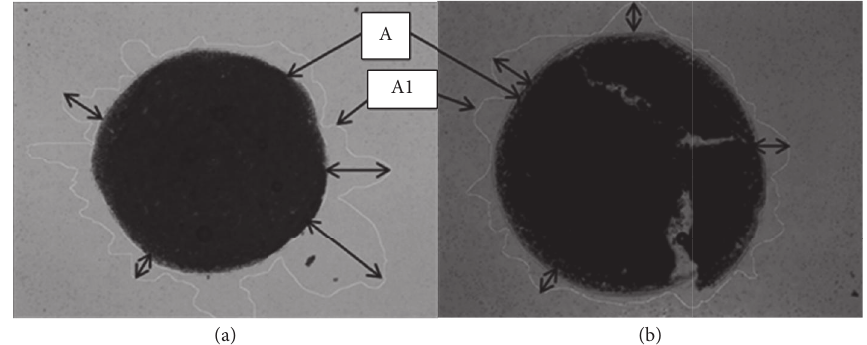
Figure 9: Representative images of exclusion zone development next to pellets of QE-RES (a) and Si-RES (b), also detailing the use of the Image J software to obtain area measurements. Double-sided arrows represent a few of the marked EZs.